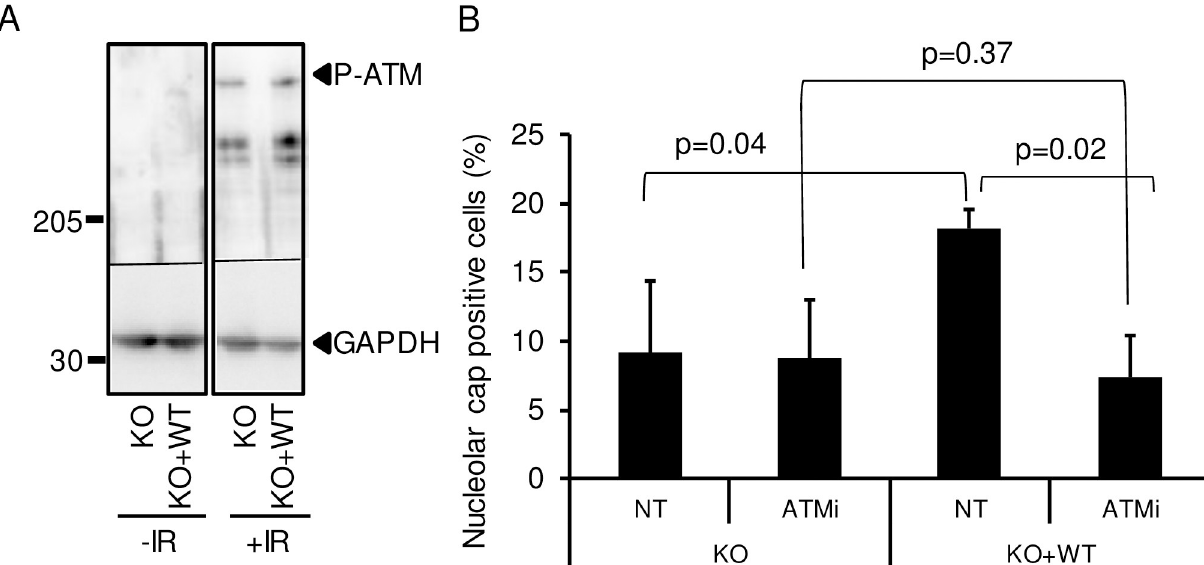
Fig 9. ATM activation in JMJD6 defective cells. (A) Western blot analysis of ATM activation in response to IR (20 Gy 1h post IR) performed by the detection of the phosphorylated form of ATM. The smaller bands induced upon irradiation are probably shorter forms of P-ATM. (B) Dependence on ATM activity for the formation of nucleolar caps in response to IR. Cells were treated or not with the ATM inhibitor. A minimum of 100 cells were counted for each condition in each independent experiment. Results are the mean +/- standard deviation from three independent experiments. The p values of the difference between the indicated samples are indicated (Student t